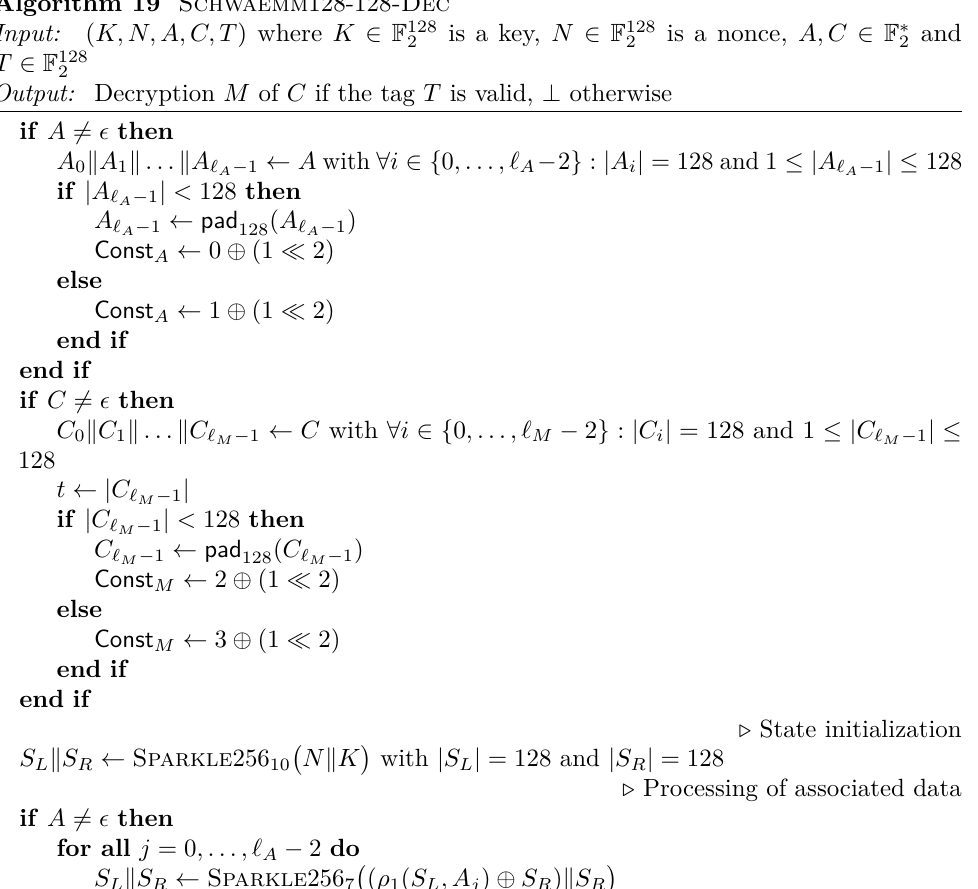
Algorithm 19 Schwaemm 128-128